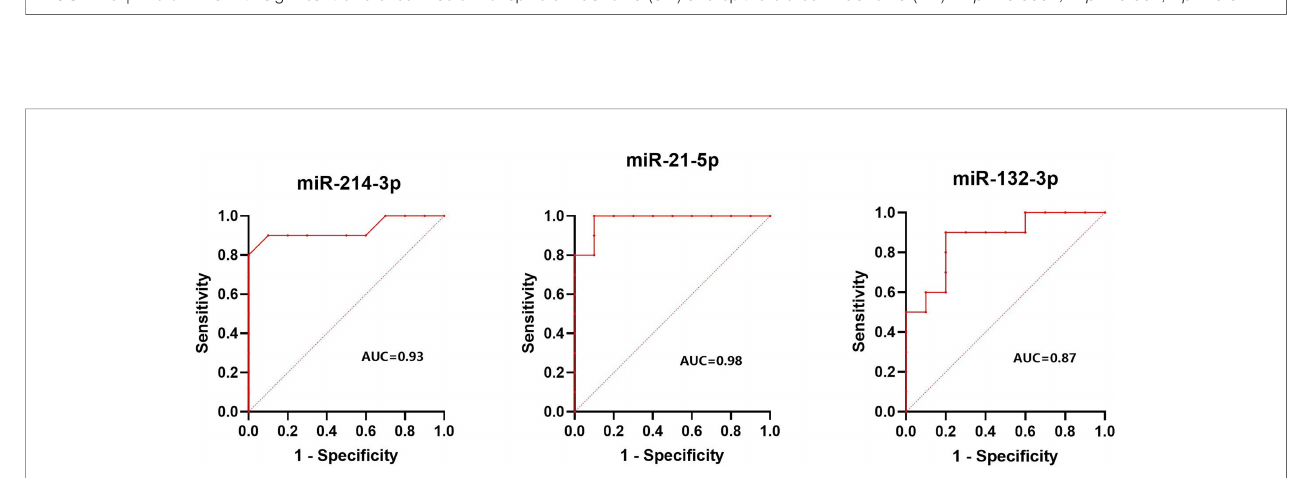
FIGURE 6 | MicroRNAs with signi fi cant difference in serum of spindle melanoma (SM) and epithelioid cell melanoma (EM) **** p < 0.0001, *** p < 0.001; ** p < 0.01.